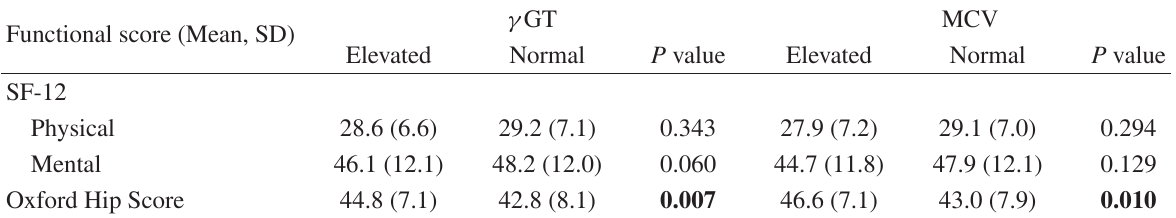
TABLE 1: Mean Functional Scores at preoperative assessment in patients with normal and elevated biomarker.